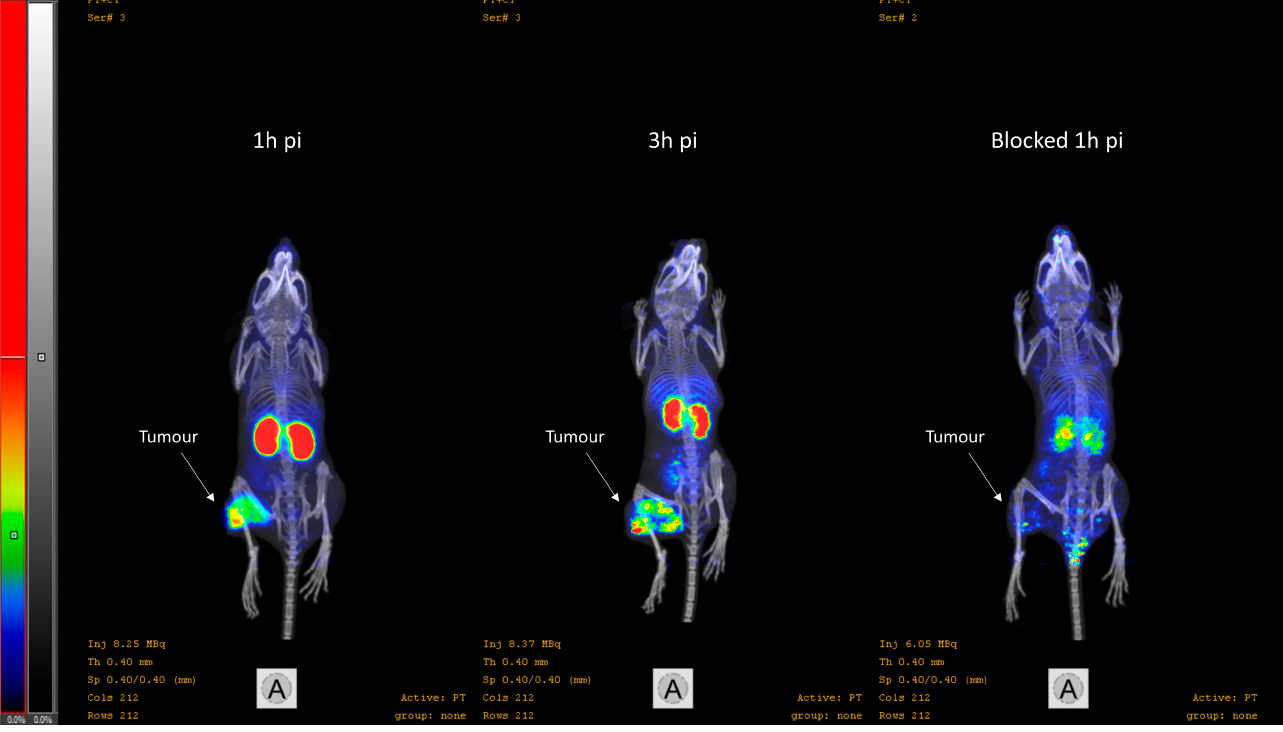
Figure 7. Representative nanoScan PET/CT images of PC3-pip xenografted mice injected with [ 68 Ga]Ga-BQ7812 (100 pmol, 8 MBq). To the left: 1 h pi.; in the middle: 3 h pi.; to the right: PSMA and GRPR blocked at 1 h pi.